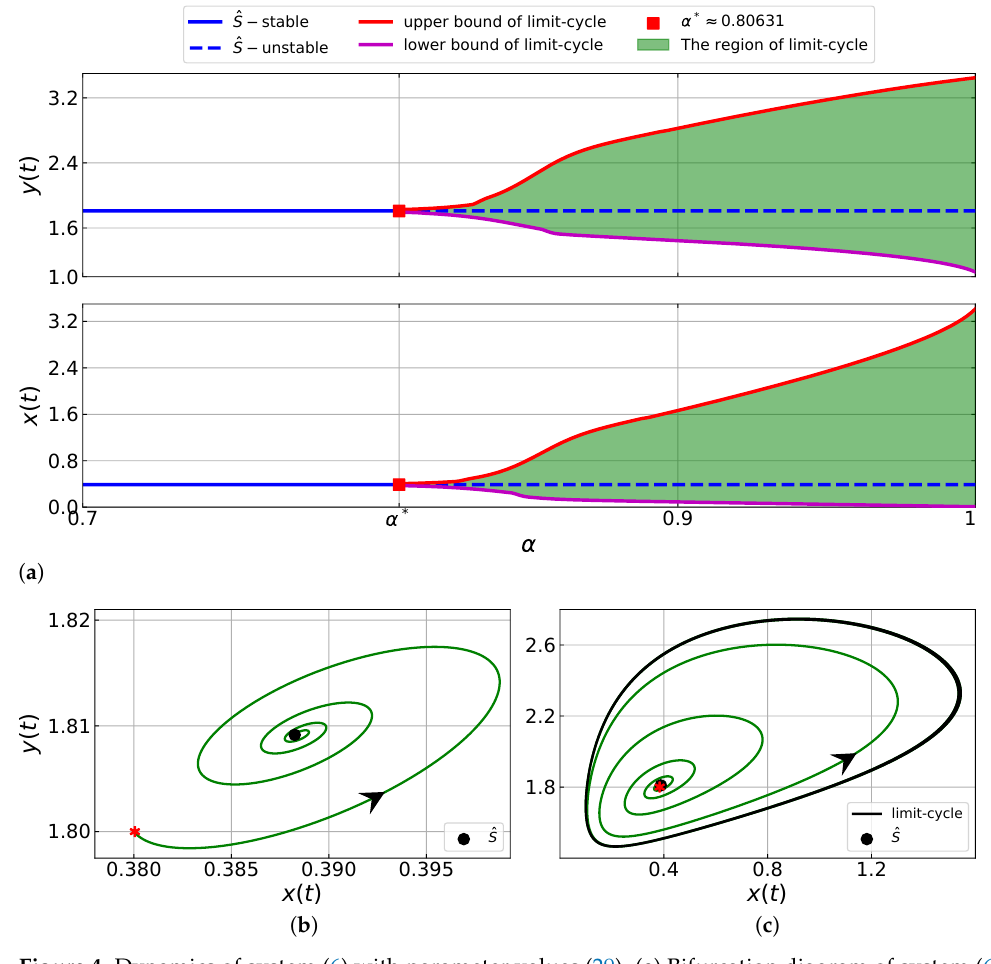
Figure 4. Dynamics of system (6) with parameter values (29). ( a ) Bifurcation diagram of system (6) driven by α . ( b , c ) Phase-portrait of system (6) with ( b ) α = 0.73 and ( c ) α =